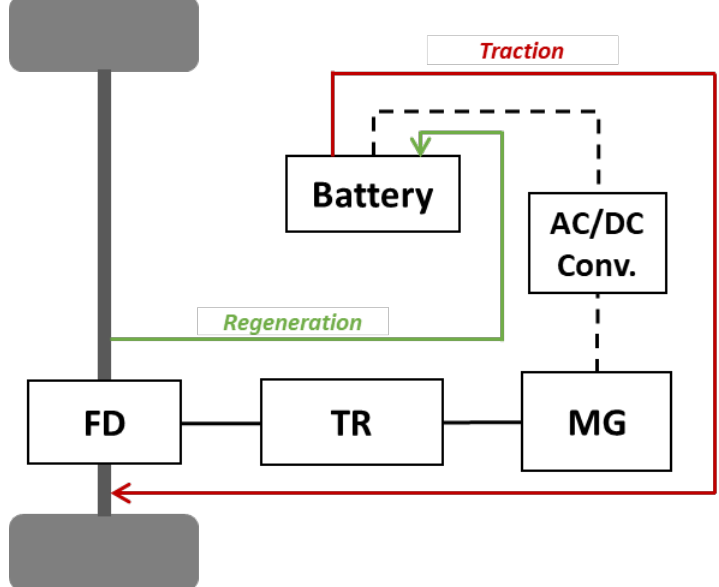
Figure 1. Scheme of the BEV model with the main energy flows.